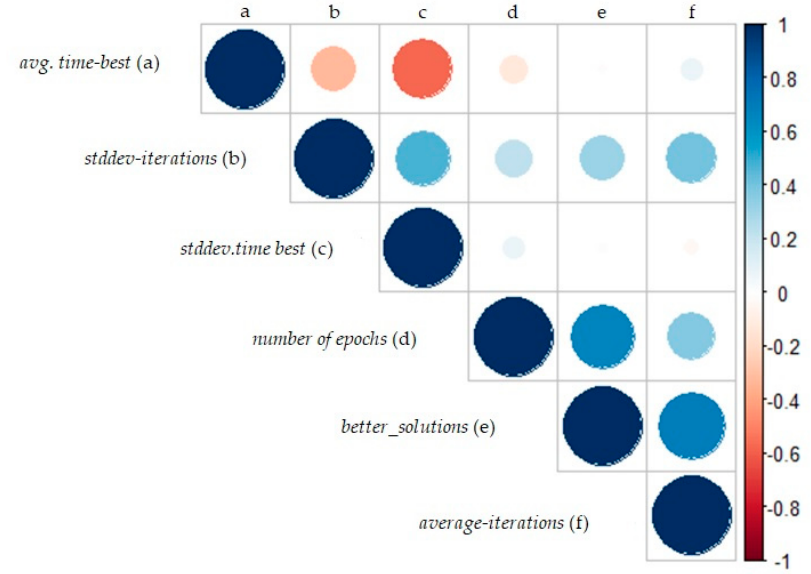
Figure 3. Correlogram of the time-performance metrics avg.time-best, stddev-best, stddev.time best, average-iterations, better_solutions and number of epochs for average-iterations, better_solutions and number of epochs for rl1889.